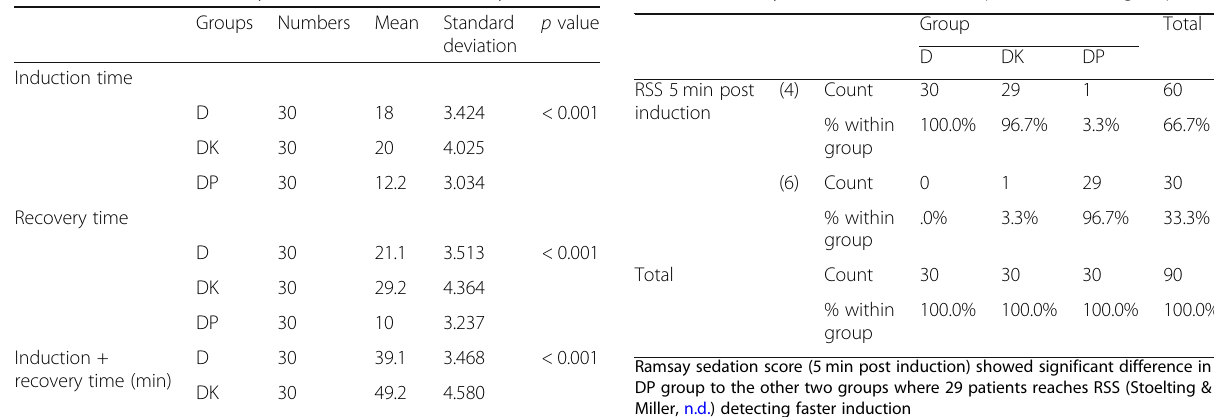
Table 6 Induction, recovery, and induction + recovery time